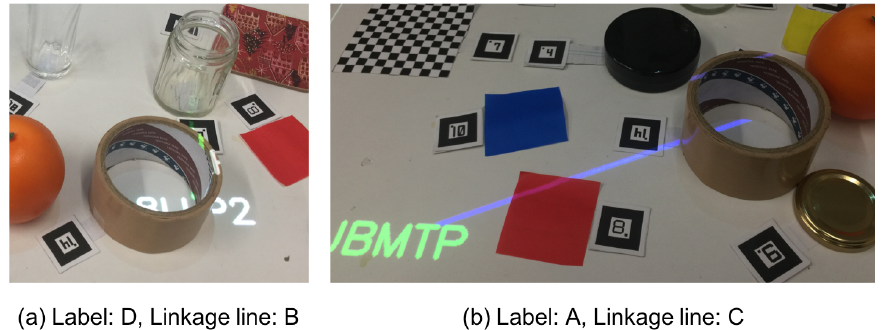
Figure 14. Examples of resultant projection that matches the participants’ evaluations with the system’s decisions, e.g., zero-gaps. The pictures were taken from the participants’ viewpoints. By contrast, 24% of label placement and 27% of linkage line placement were classified incorrectly.